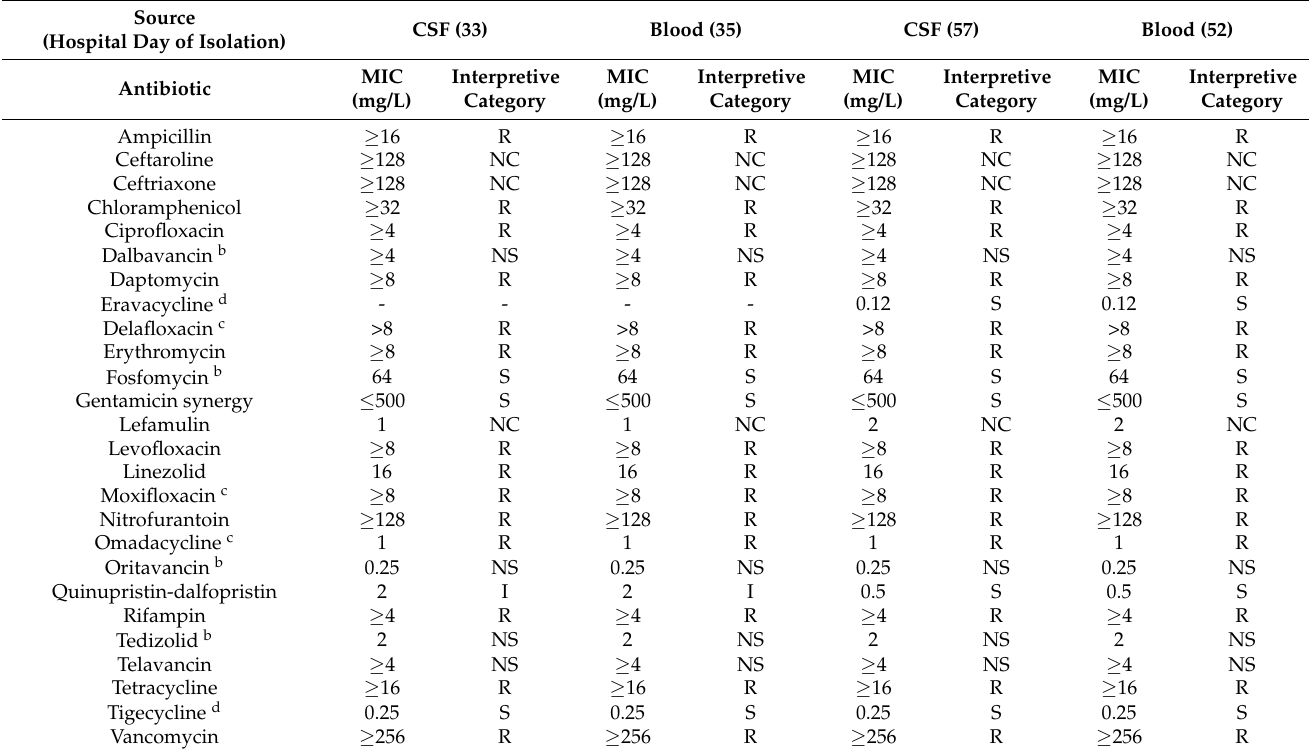
Table 1. Phenotypic susceptibilities and interpretive categorya of VREf isolates to tested antimicrobials a . Source (Hospital Day of Isolation)